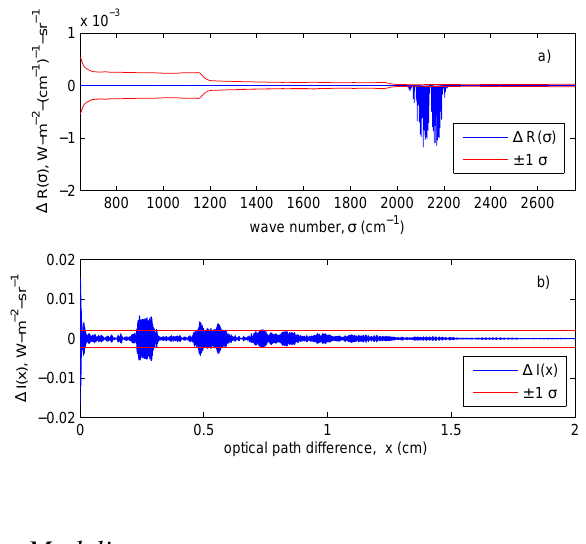
Figure 3. Illustrating the property of the Fourier transform to project sharp and narrow-band spectral features in small-amplitude, broad-band signals. Panel (a) shows the difference of a synthetic IASI spectrum against a reference with zero load of CO. Panel (b) shows the corresponding variation in the interferogram, ∆ I ( x ) . The noise level ( ± 1 σ tolerance interval) is shown for comparison, as